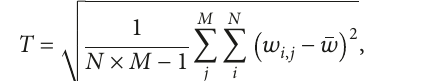
Figure 8: CSA result with threshold T = 0 1 or 0.2.